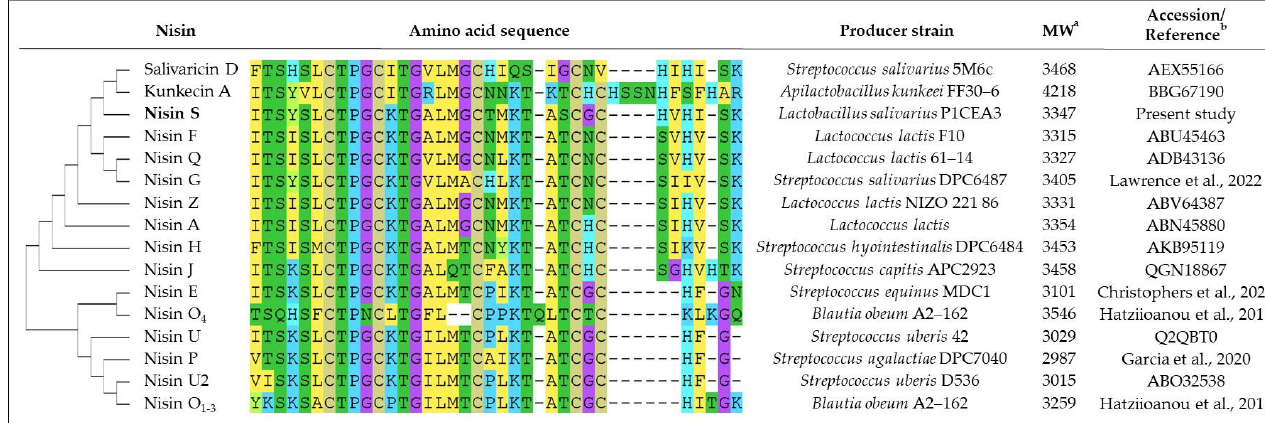
Figure 3. Dendrogram and multiple-sequence alignment of mature nisin variants, including NisS (in bold), observed molecular weight (MW), and accession number. For alignment and phylogeny reconstruction of the nisin variants, the MEGA11 software was used [35]. a Molecular weight (MW) of nisin variants in daltons, and b reference is given when the accession number is not available